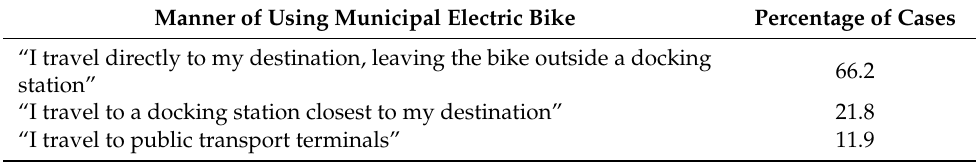
Table 8. In what circumstances do you use MEVO municipal bikes most often? ( n =